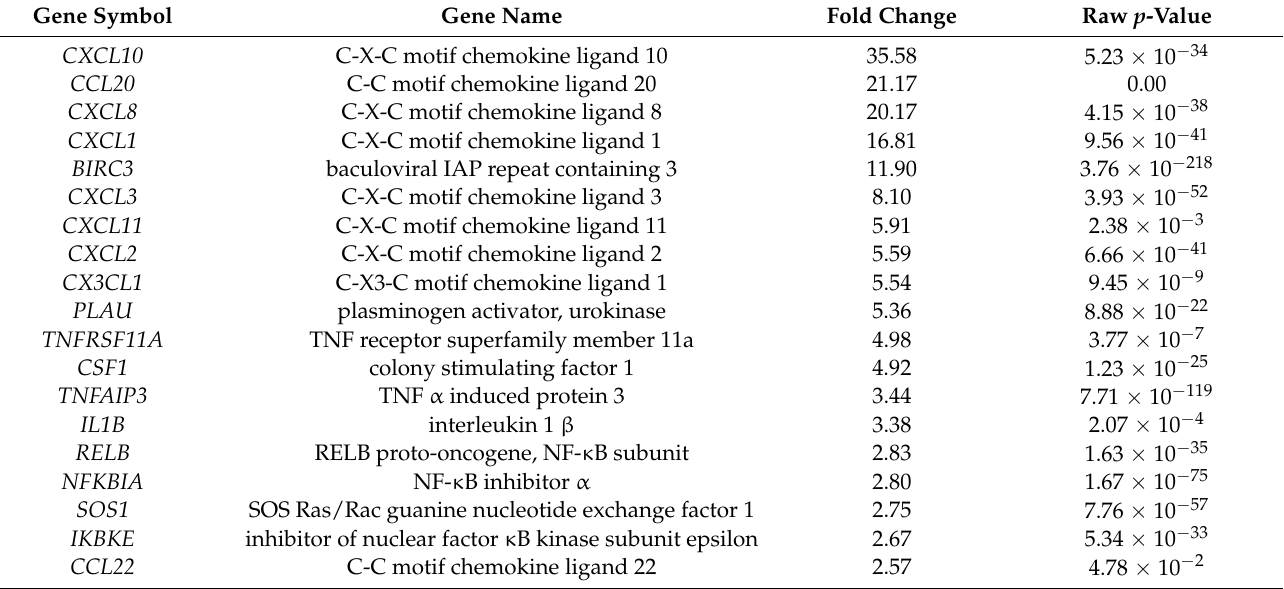
Table 3. List of genes involved in immune response in Caco-2 cells stimulated with